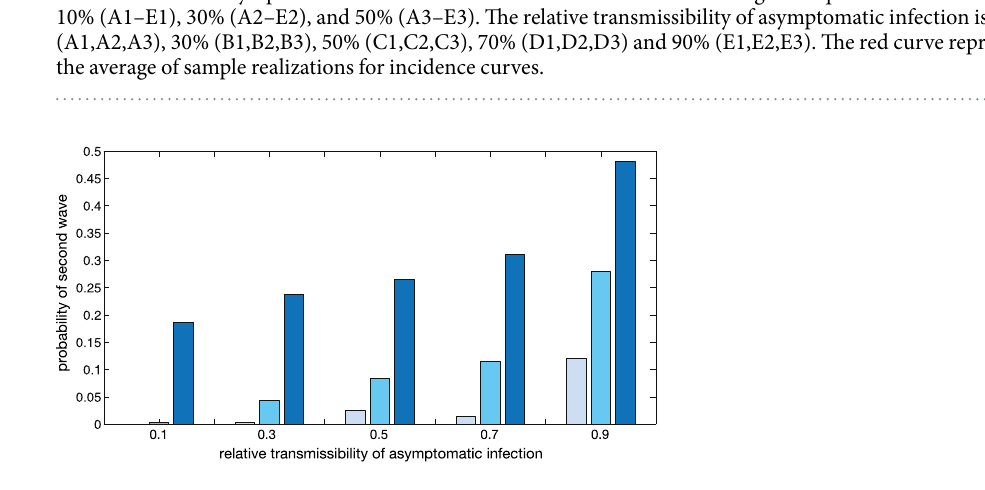
We estimated the cumulative number of ZIKV infection resulted from the virus transmission through sexual encounter. Figure 5 shows the range of these estimates for different relative transmissibility of asymptomatic infection in the absence of any control measure (blue bars). For a low relative transmissibility (10%), the median number of sexual transmission is 10.6 (Range: 0, 31.5), which accounts for 1.16% of the cumulative incidence